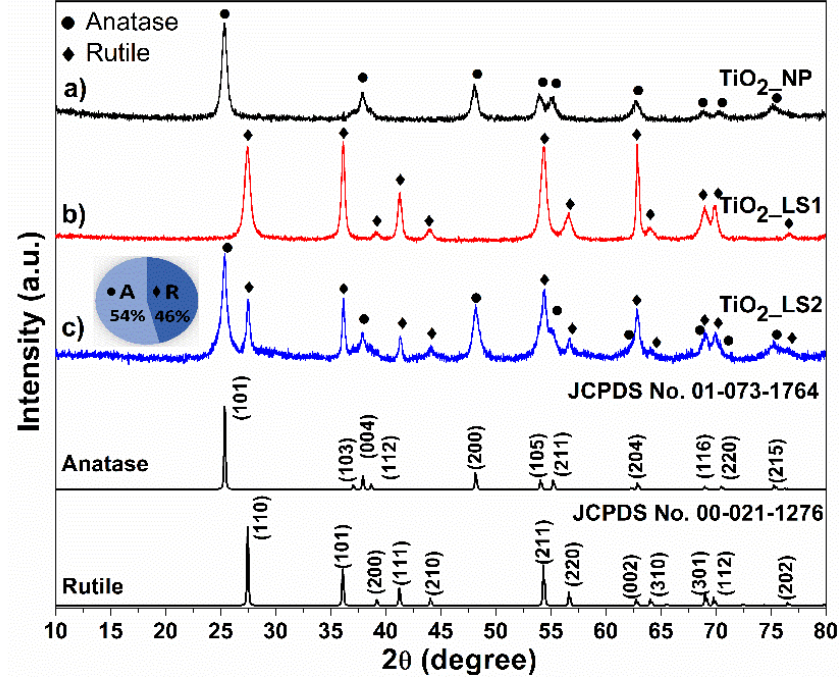
Figure 3. X-ray diffraction pattern of (a) TiO 2 _NP, (b) TiO 2 _LS1, and (c) TiO 2 _LS2 obtained at room temperature.